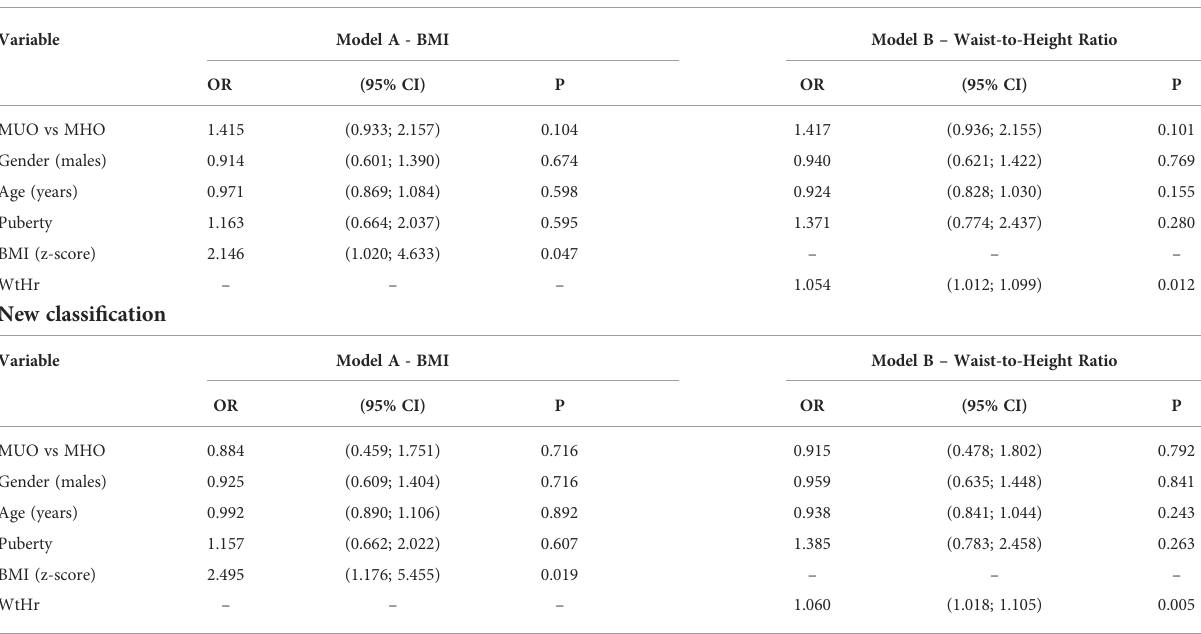
TABLE 3 Effect of metabolically unhealthy obese phenotype, gender, age, puberty, BMI (Model A) or waist-to-height ratio (Model B) on left ventricular hypertrophy by a multiple logistic regression model.